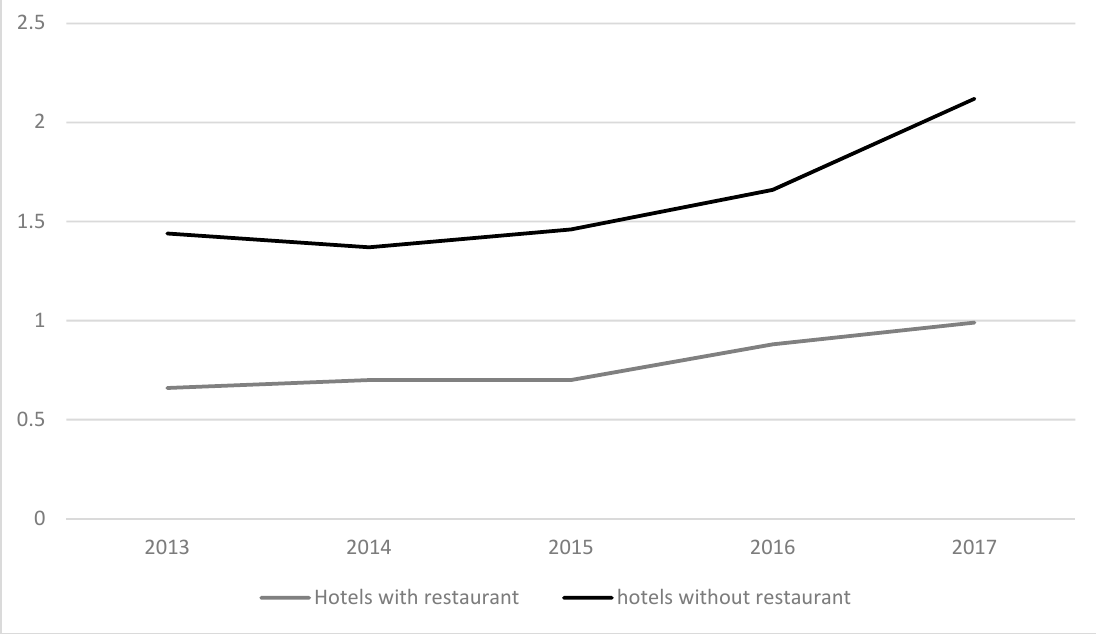
Figure 6. Quick Ratio, with and without a restaurant. The STAR variable is very important in the hospitality sector, influencing several ra- tios. Then through the test, it was analyzed whether the liquidity ratios vary according to the classification of the hotels in official star terms (Table 11). Table 11. Results of non-parametric Kruskal–Wallis test to verify if STAR presents equal distribution. Null Hypothesis